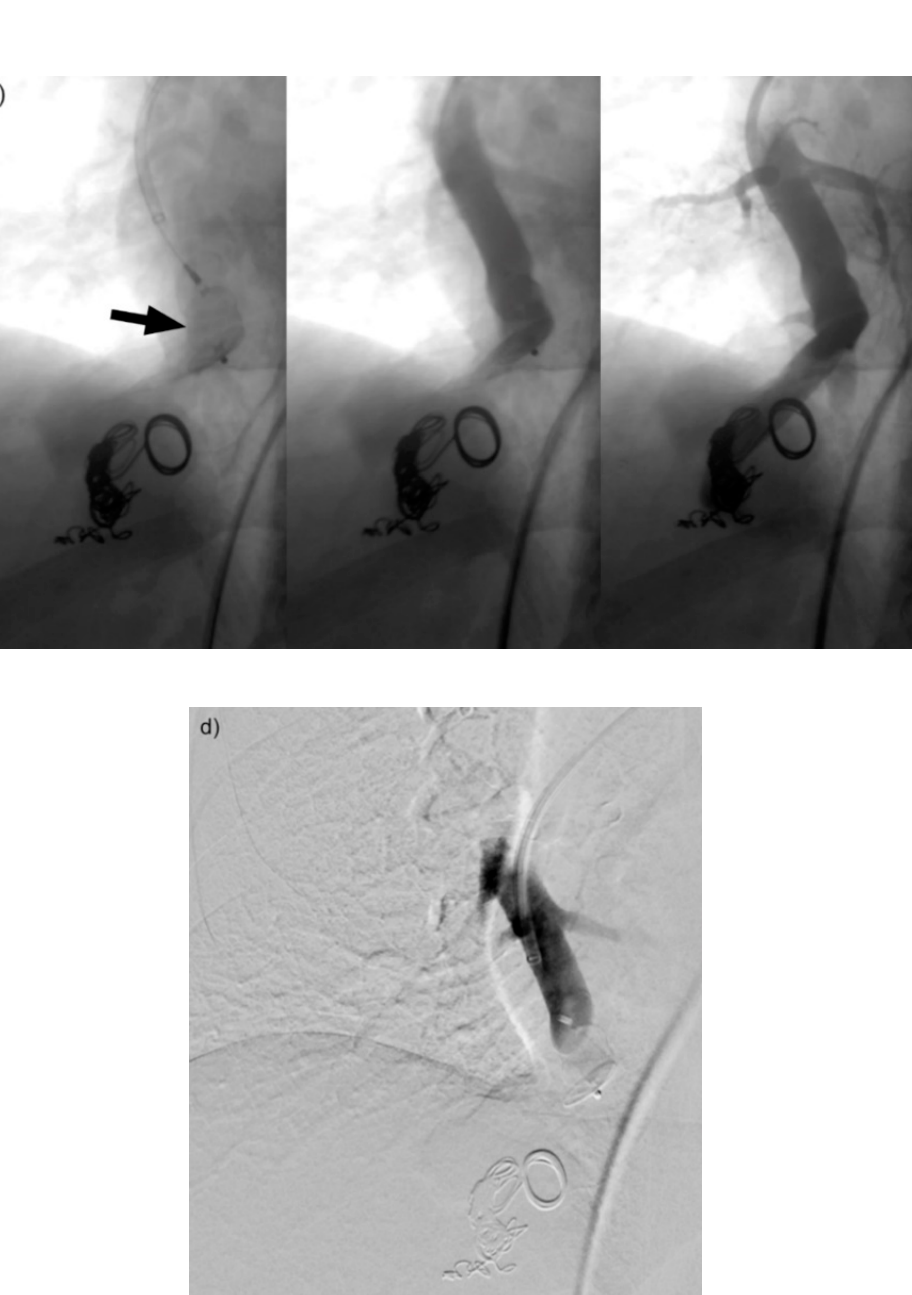
Figure 4. ( a – d ) A giant re-perfused PAVM in the lower right lobe. In this case, pre-interventional DSA ( a ) shows two large feeding vessels originating from a common trunk, resulting in embolization being performed at the level of the bifurcation. With DSA performed just after implantation, ( b ) shows the amplatzer plug II still connected to the wire. Optimal positioning is depicted. The dynamic series in ( c ) shows the vascular plug (arrow) still penetrable to contrast medium, however, flow is already reduced. At 5 min post-implantation of the vascular plug ( d ), the feeding artery of the re-perfused PAVM is completely occluded.